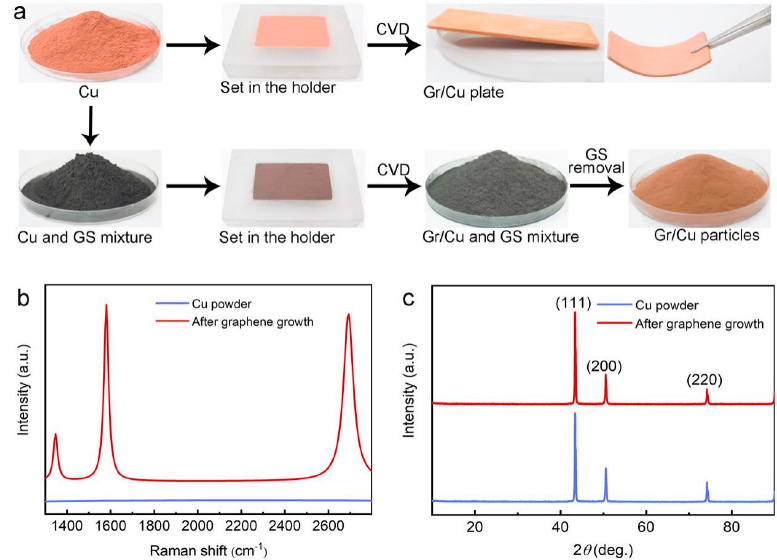
Figure 1. ( a ) Schematic diagram of the synthesis process of monodisperse Gr/Cu microparticles by thermal chemical vapor deposition (CVD); ( b ) Raman and ( c ) X-ray diffraction (XRD) spectra of Cu powder before and after graphene growth.